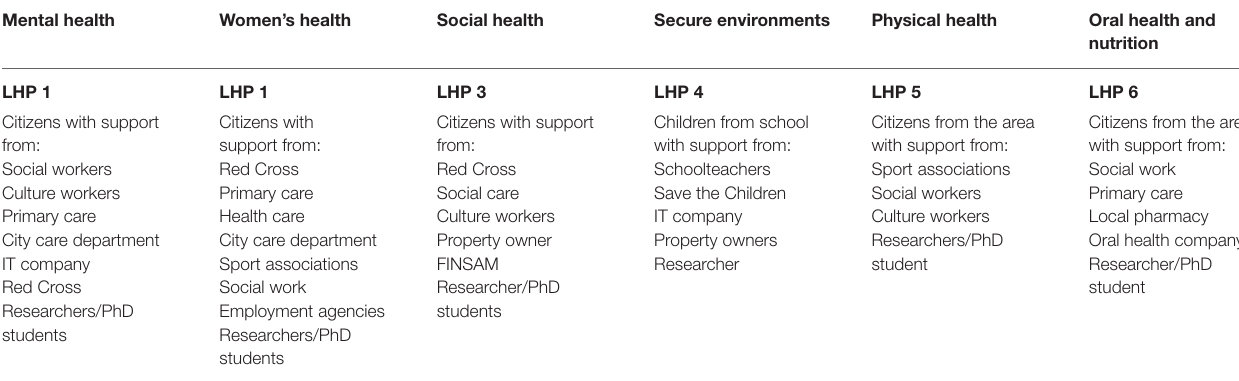
TABLE 2 | Overview of actors involved in the six health promotion